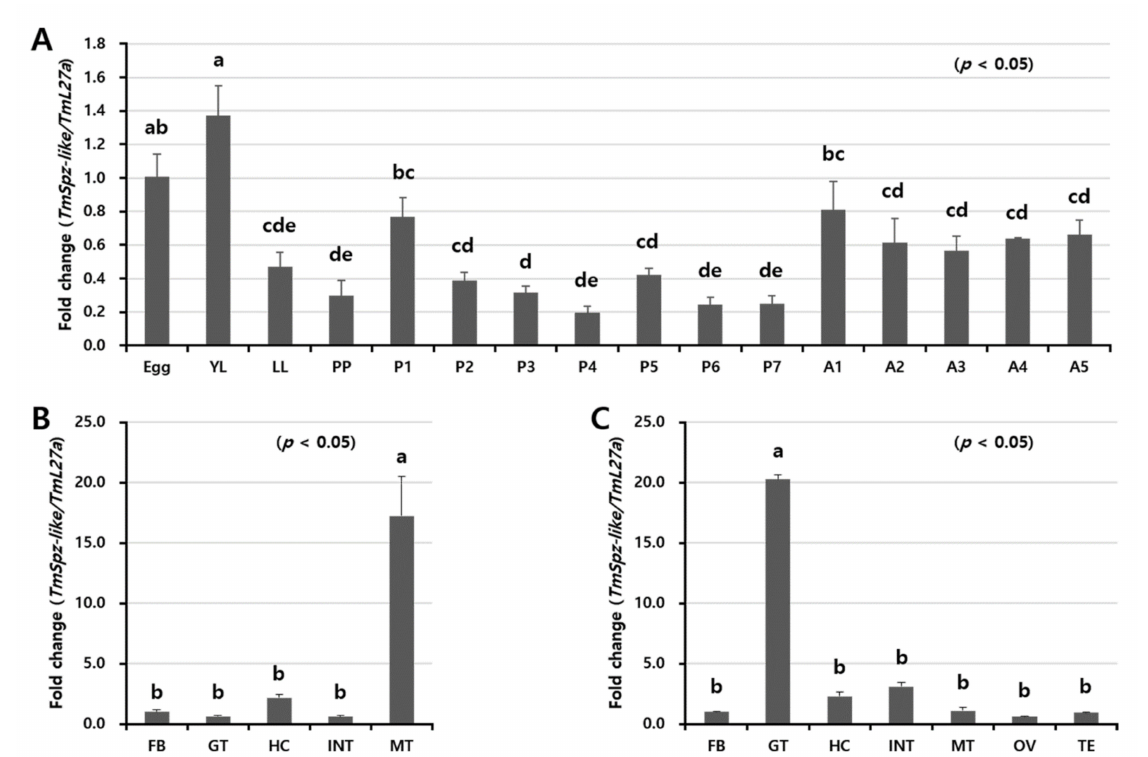
Figure 3. Relative expression levels of TmSpz-like mRNA in different developmental stages and tissues of Tenebrio molitor . ( A ) Expression levels of TmSpz-like in T. molitor at the egg, the young larval (YL), late larval (LL), pre-pupal (PP), 1–7-day-old pupal (P1–7), and 1–5-day-old adult (A1–5) stages. Tissue distribution of TmSpz-like transcripts in late larvae ( B ) and five-day-old adults ( C ) analyzed using quantitative real-time polymerase chain reaction. T. molitor 60S ribosomal protein L27a ( TmL27a )-encoding gene was used as an internal control. Fat body (FB), gut (GT), hemocytes (HC), integument (INT), and Malpighian tubules (MT) of late instar larvae and adults, in addition to ovaries (OV) and testes (TE) of adults, were dissected and collected from 20 late larvae and 5-day-old adults for analysis. Vertical bars represent mean ± standard error from three biological replicates. Data were analyzed using one-way analysis of variance, followed by Tukey’s multiple range tests at 95% confidence level ( p < 0.05). The graphs indicated by the same letter (a, b, bc, c, cd, d, de, e) are not significantly different (Tukey’s multiple range; p <